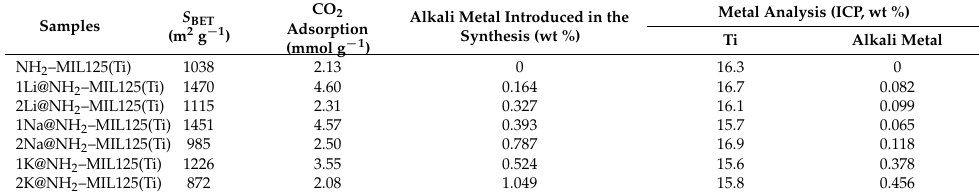
Table 1. Textural properties of NH 2 –MIL125 doped with different amounts of alkali metal.